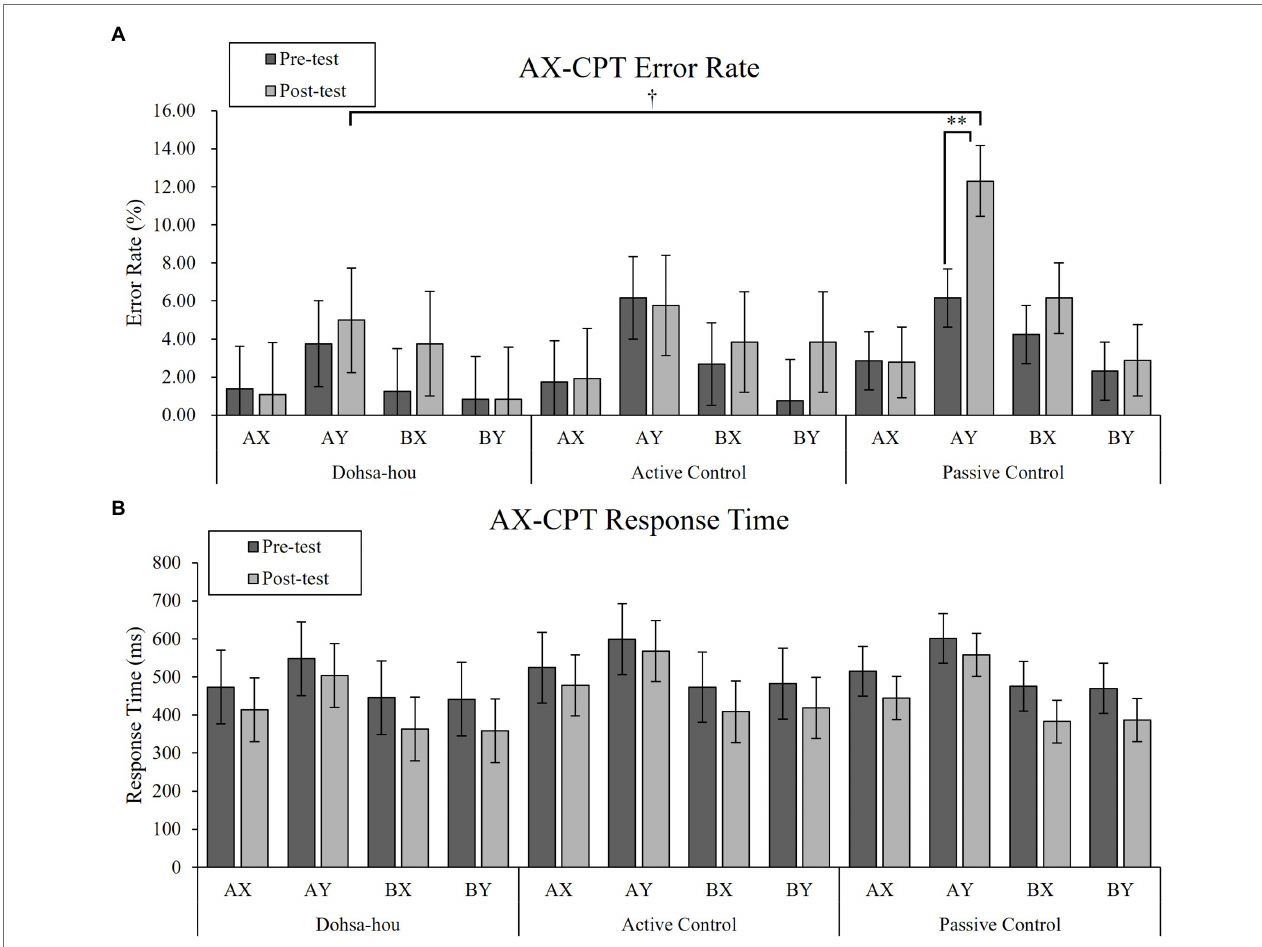
FIGURE 2 | The error bars represent standard error of the mean. (A) Mean error rate of the AX-CPT for each group, each test time, and each trial type. (B) Mean response time of the AX-CPT for each group, each test time, and each trial type. Asterisks represents a significant difference. † p < 0.10; ** p <